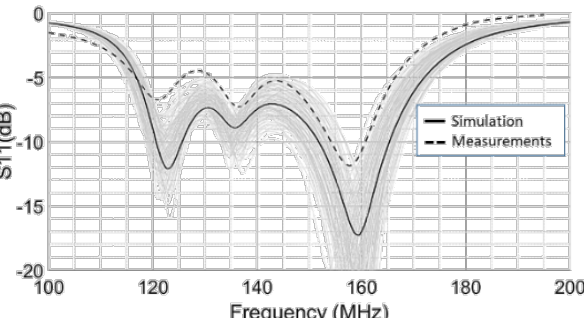
Figure 15. Measured and simulated reflection coefficient S11 of the matched antenna A5 including the sim-ulated individual component tolerances effects..